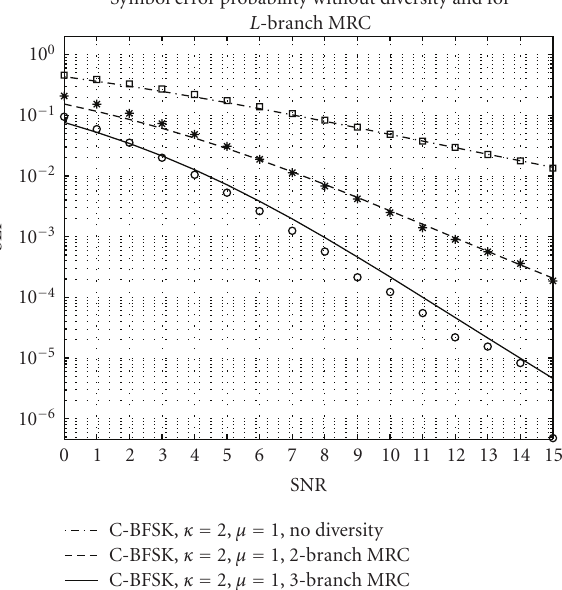
Figure 16: BEP/SEP for coherent detection, L = 1, 2,